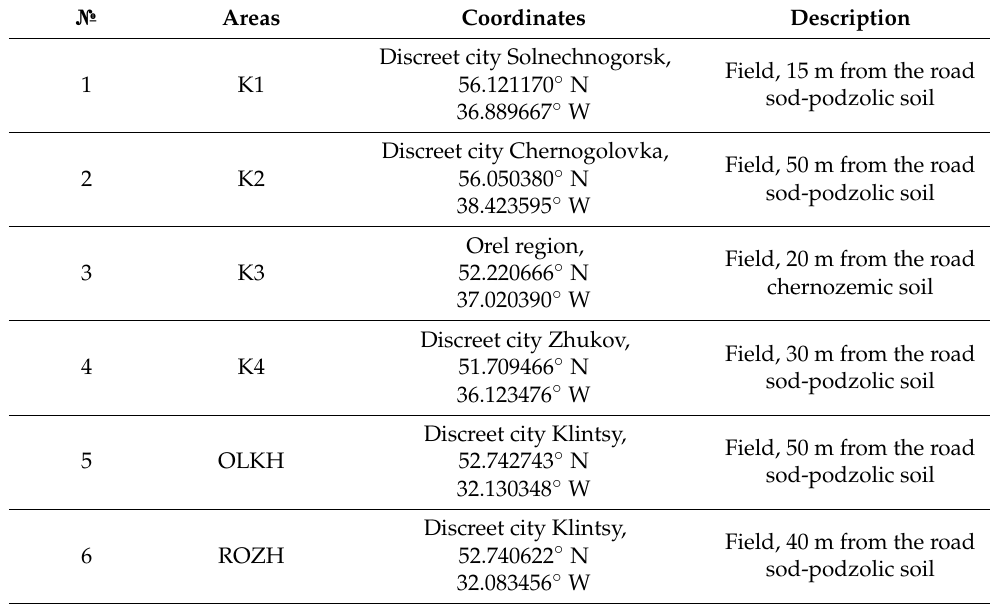
Figure 1. Location of control and experimental areas. The map was created based on the Google Maps service and modified in CorelDraw Graphics Suite 2021. The explanation for numbers in the figure is presented in Table 1. The levels of radioactive contamination are given for 2006 by data from International Atomic Energy Agency (IAEA) [23]. Table 1. Characteristics of experimental areas.